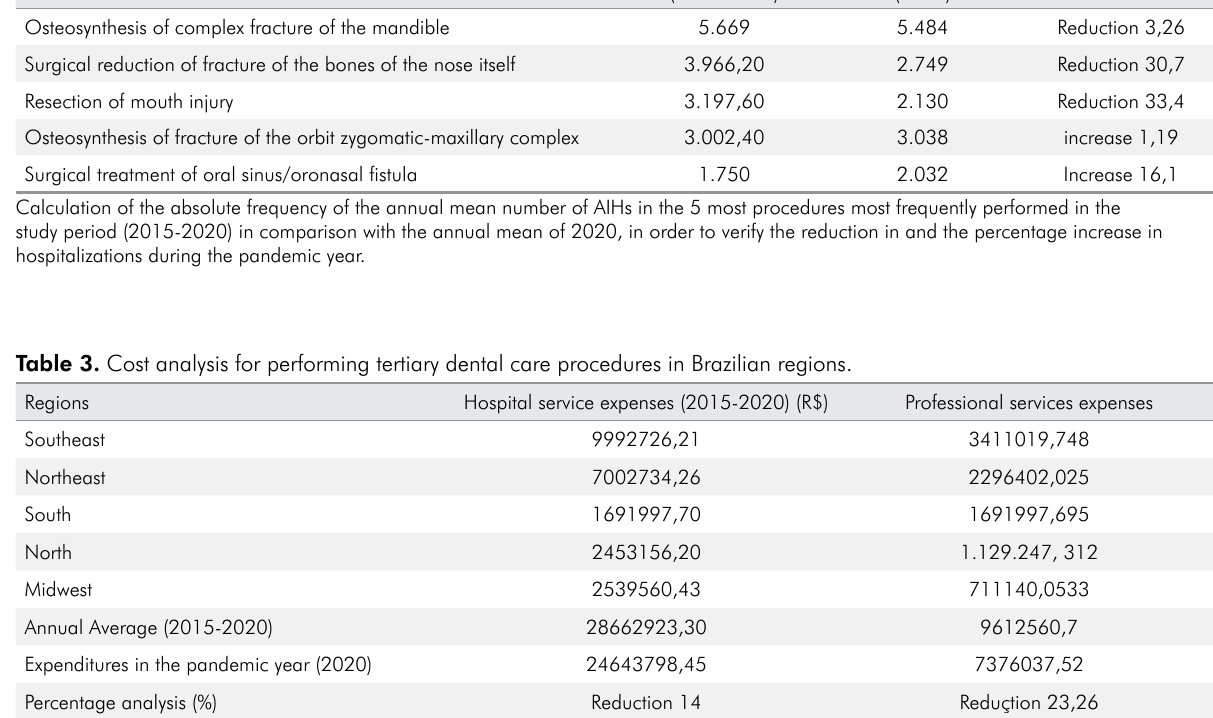
Table 2. Descriptive analysis to verify the reduction / percentage increase in the approval of the 5 most procedures most frequently performed in the study period (2015-2020).